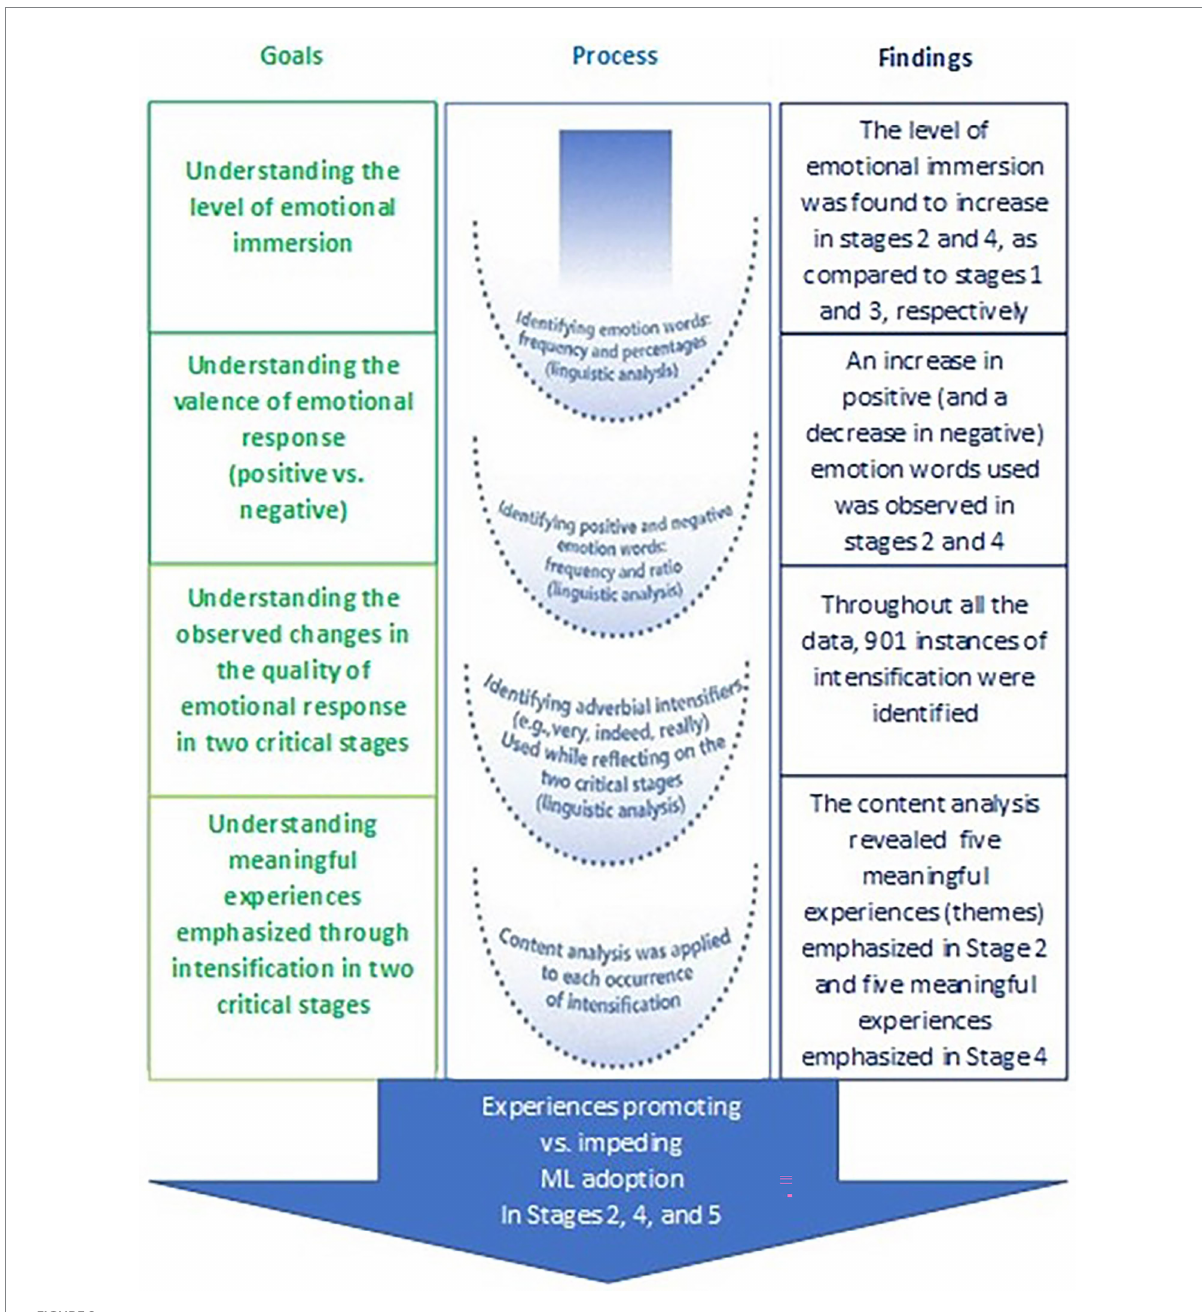
FIGURE 2 Experiences promoting vs. impeding ML adoption in Stages 2, 4, and